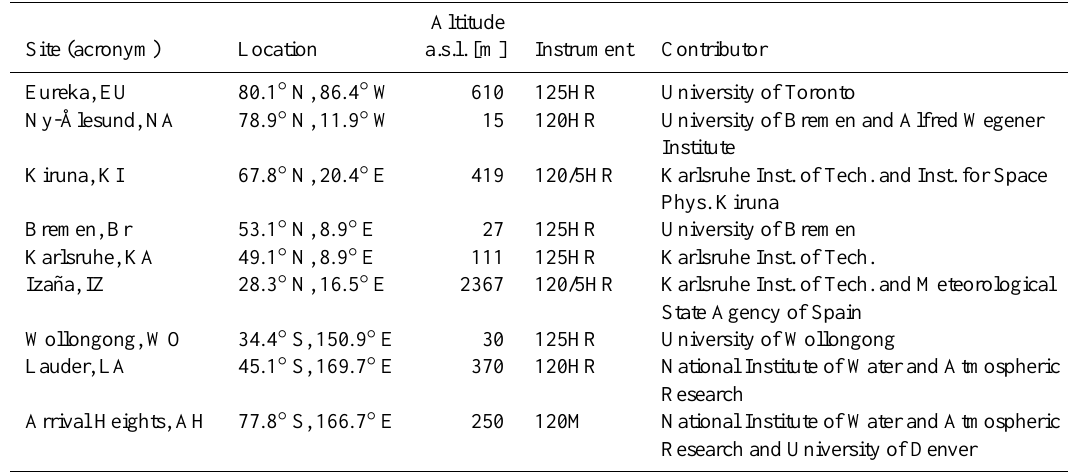
Table 1. Ground-based NDACC FTIR contributing